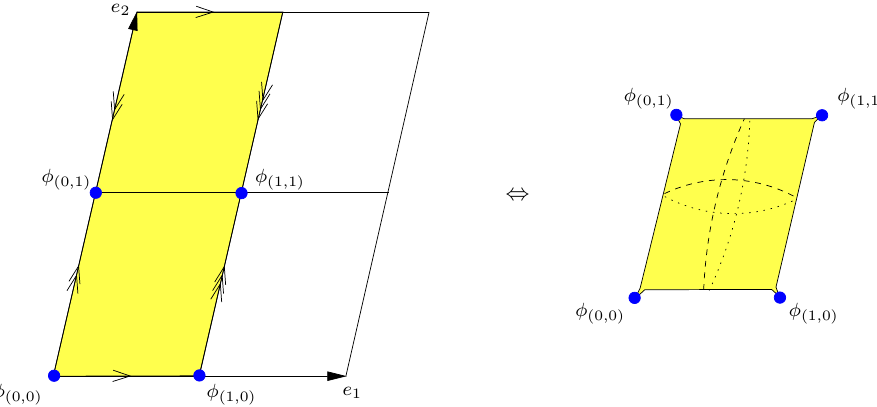
Figure 1 . The T 2 / Z 2 orbifold. Left: the two-torus T 2 is defined by a two-dimensional lattice, spanned by the vectors e 1 and e 2 . The Z 2 orbifold twist θ = − 1 2 maps the fundamental domain of T 2 to the fundamental domain of the orbifold, depicted in yellow. The orbifold action y 7→ θ k y + e n has four inequivalent fixed points, indicated by blue bullets. Localized at these fixed points, there are four (left-chiral) twisted strings ( φ yellow fundamental domain are identified according to the arrows. Right: after identifying the boundaries of the fundamental domain, the T 2 / Z 2 orbifold has a pillow-like shape with the four fixed points at the corners of the pillow (or